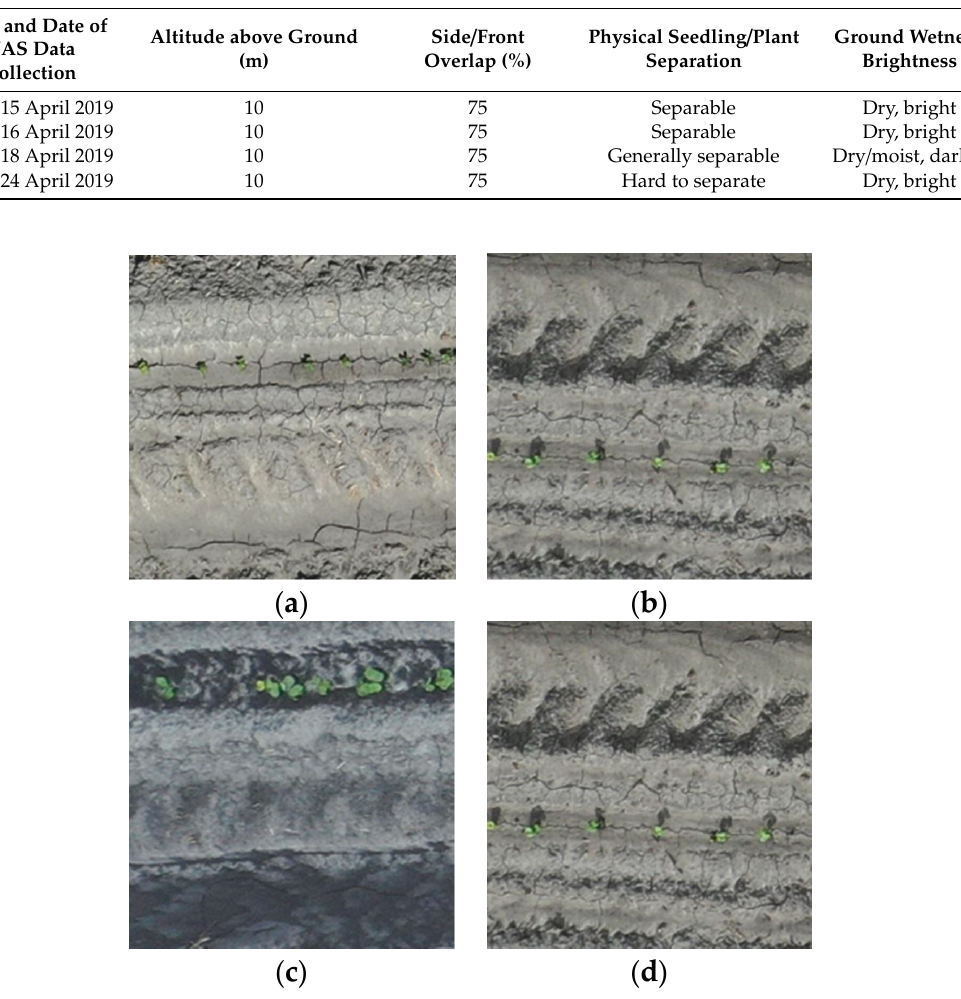
Figure 2. Temporal variation in overall illumination, soil wetness, and plant size from zoomed-in images (416 × 416 pixels) of raw Unmanned Aircraft Systems (UAS) data collected on ( a ) 15 April, ( b ) 16 April, ( c ) 18 April, and ( d ) 24 April. Each image was taken from different locations.